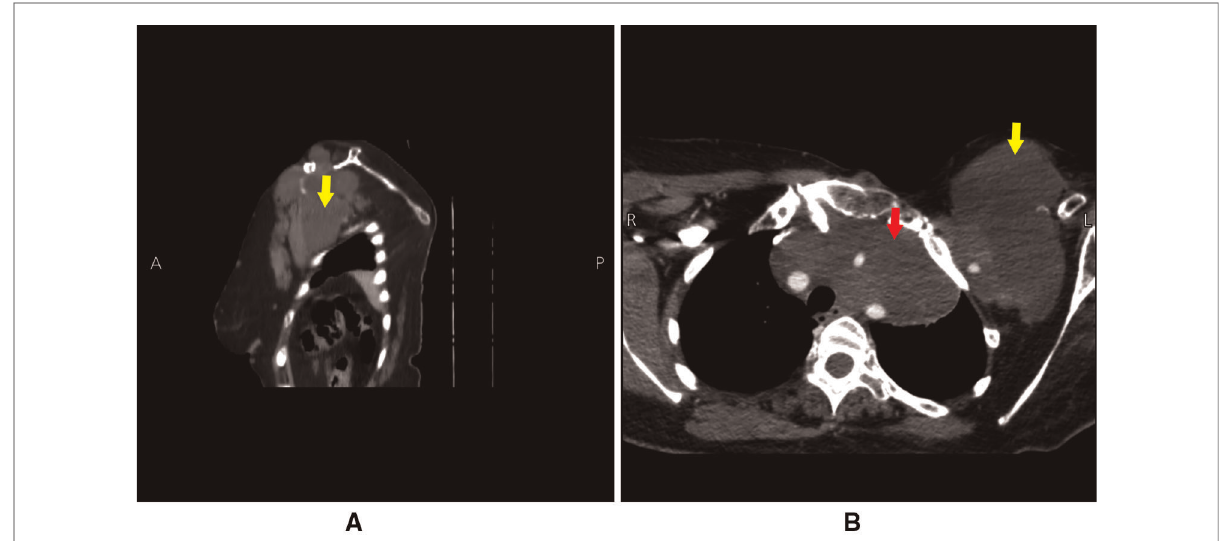
FIGURE 1 CT scans done in June 2021 showing a large lobulated hypodense mass lesion. Red arrow indicates the mediastinal lesion, yellow arrows indicate the extrathoracic chest wall